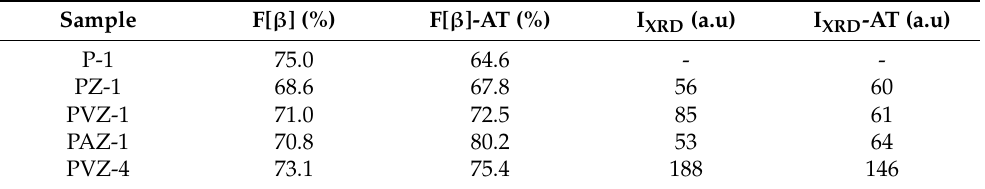
Table 2. Beta phase fraction (F[ β ]) and peak intensity 101 (IXRD) for samples before and after (AT) photocatalytic oxidation